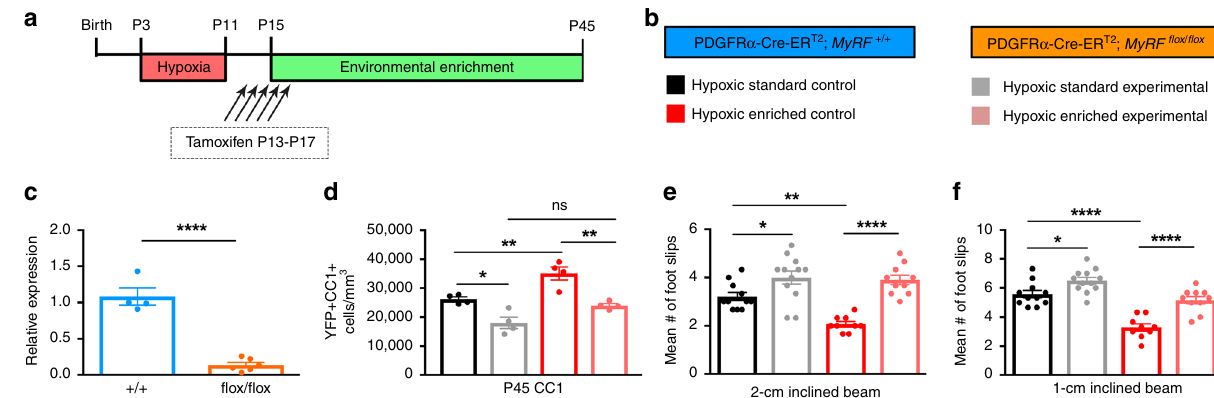
Fig. 7 De novo oligodendrocyte generation is required to promote functional recovery induced by environmental enrichment. a Experimental paradigm. Mice received tamoxifen once daily from P13 to P17. b Experimental groups. c Quantitative PCR for MyRF mRNA levels in white matter of wild-type (MyRF + / + , n = 4) and knockdown (MyRF fl / fl , n = 6) mice at P30 (two-tailed unpaired t test, **** p < 0.0001). d Quanti fi cation of total YFP + CC1 + OLs at P45 ( n = 4 per group) (from left to right: * p = 0.015, ** p = 0.009, ** p = 0.002). e , f Quanti fi cation of foot slips on 2-cm inclined beam (* p = 0.04, ** p = 0.003, **** p < 0.0001) ( e ) and 1-cm inclined beam (* p = 0.04, **** p < 0.0001) ( f ) at P45 (MyRF + / + HX Control, n = 11 animals; MyRF + / + HX-EE Co n trol, n = 9 animals; MyRF fl / fl HX Experimental, n = 12 animals; MyRF fl / fl HX-EE Experimental, n = 10 animals). Data are expressed as mean ± SEM. One-way ANOVA followed by a Tukey ’ s post hoc test for multiple comparisons was used to compare differences between groups. Source data are provided as a Source Data fi